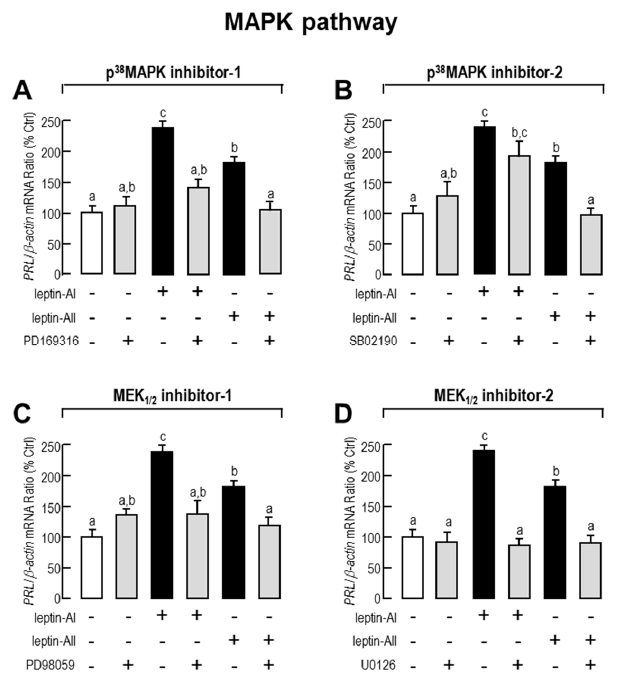
Figure 5. Effects of MAPK signal pathway blockers on leptin-stimulated PRL mRNA levels in primary cultured goldfish pituitary cells. Goldfish pituitary cells were treated with leptin-AI (100 nM) or leptin-AII (100 nM) in the presence or absence of p 38 MAPK inhibitors PD169316 (100 nM, A ) and SB02190 (100 nM, B ), MEK 1/2 inhibitors PD98059 (10 µ M, C ) and U0126 (200 nM, D ), for 24 h. In the